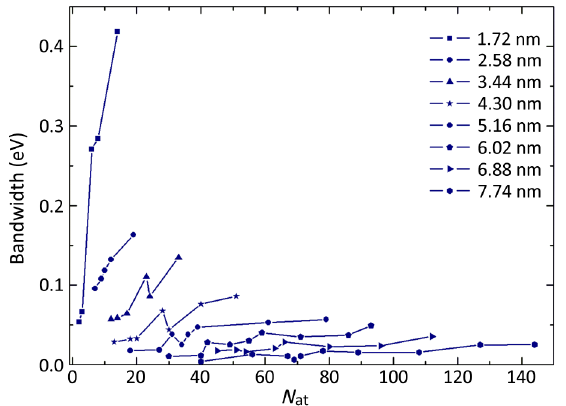
FIG. 3 (color online). Evolution of the bandwidth of the 1 S Dirac band as a function of the number of atoms that form the nanocrystal-nanocrystal contact ( N ). The size of the nano- at crystals, which also determines the period of the honeycomb lattice, is indicated by the body diagonal of the truncated nanocube. Results are shown for the graphene geometry (bonding via the f 110 g